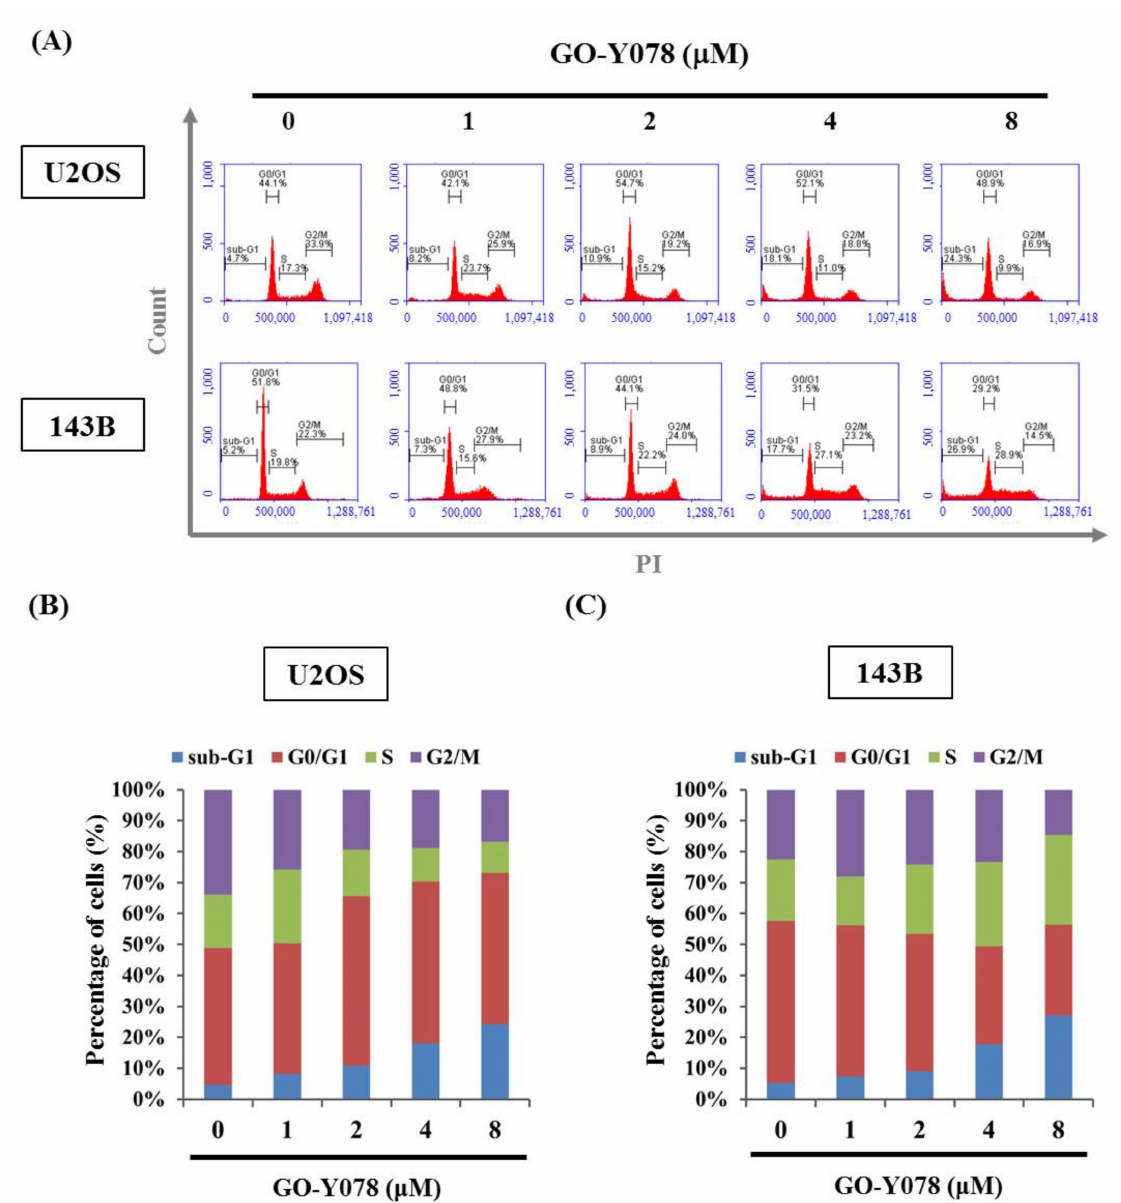
Figure 2. Effects of GO-Y078 on the cell cycle of U2OS and 143B cells. U2OS and 143B were treated with GO-Y078 (1, 2, 4, and 8 µ M) for 24 h and then subjected to flow cytometry after ( A ) propidium iodine (PI) staining to analyze DNA contents. ( B ) The cell cycle profile of ( B ) U2OS and ( C ) 143B cells in flow cytometry was subsequently